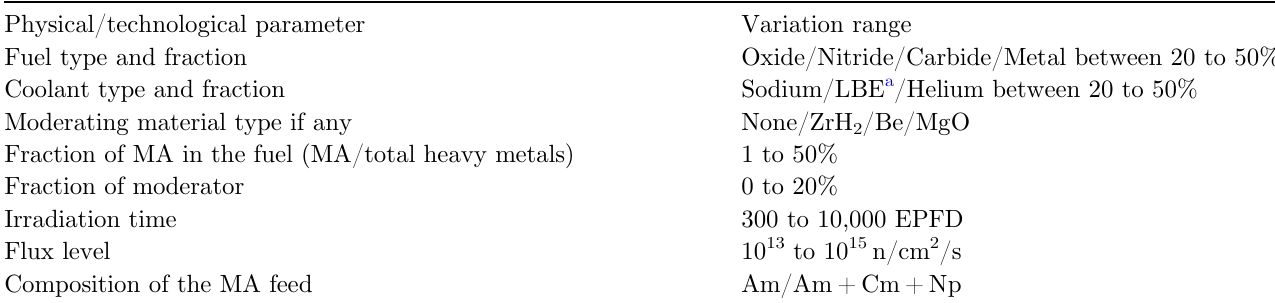
Table 1. Reactor parameters.